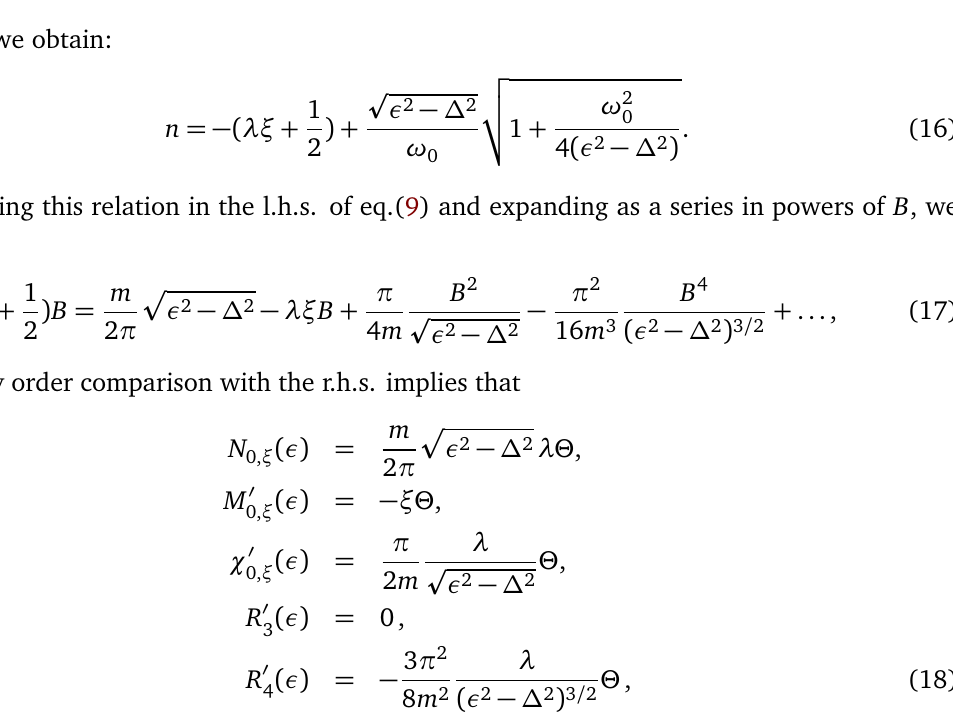
Figure 2: Gapped graphene bilayer. (a) Dispersion relation in zero field: energy (cid:200) (cid:128) (cid:138) 2 k 2 ε ( k ) = λ + ∆ 2 [ in units of ∆ ] as a function of the wavevector k [ in units of λ 2 m [ in units of ∆ ] as a function of the field B [ in units of m ∆ (b) Landau levels: energy ε n , ξ , λ different values of the Landau index ¯ n = n + 1 + λξ = 2,3 for λ = + and ¯ n = 0,1,2,3 for λ = − (here we consider a single valley ξ = + ). (c) Integrated density of states (IDoS) N ∆ ] , derivative of the magnetization M (cid:48) [ red dashed line ] and derivative of line, in units of m 2 π 0, ξ ] as a function of energy ε [ in units of [ blue dotted line, in units of π the susceptibility χ (cid:48) 2 m ∆ 0, ξ ∆ ]